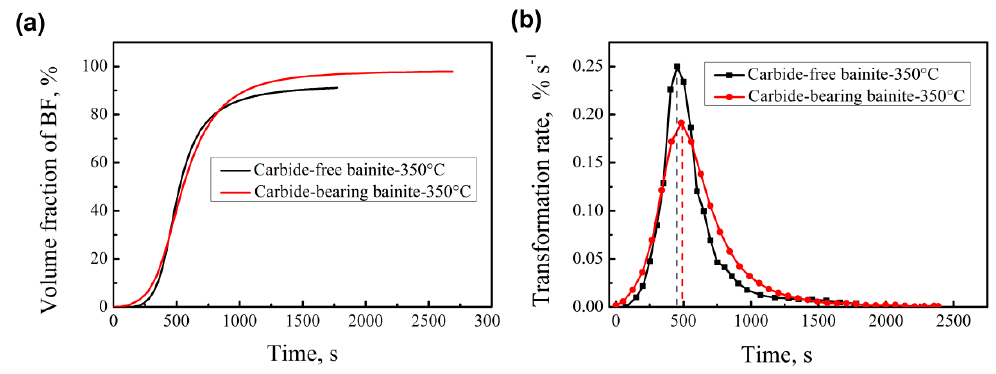
Figure 5. Relationship between the volume fraction of bainite ( a ), the transformation rate ( b ) and time.